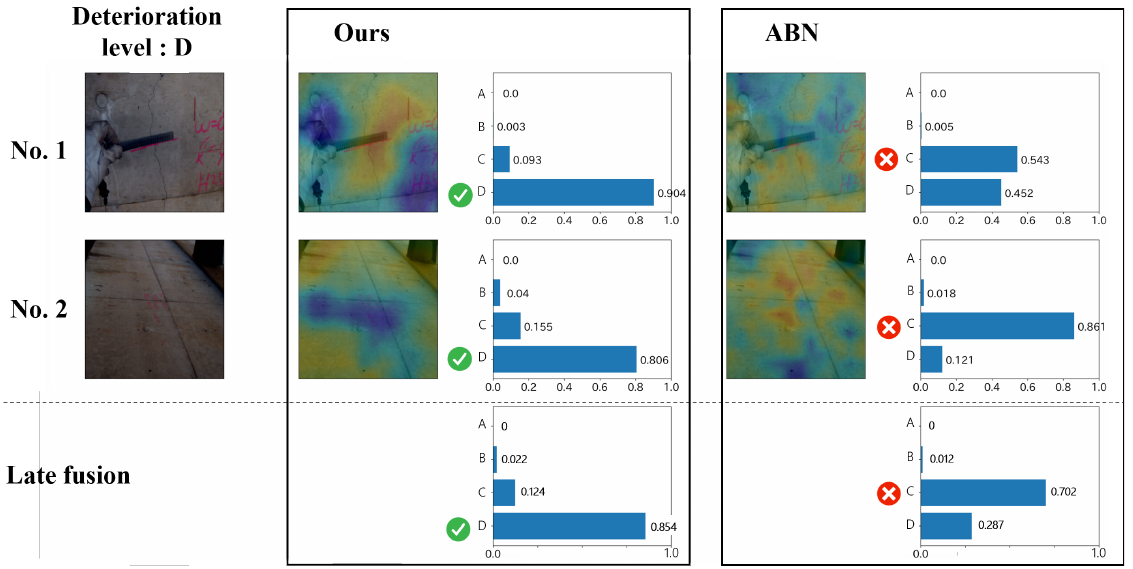
Figure 9. The example of estimation results of